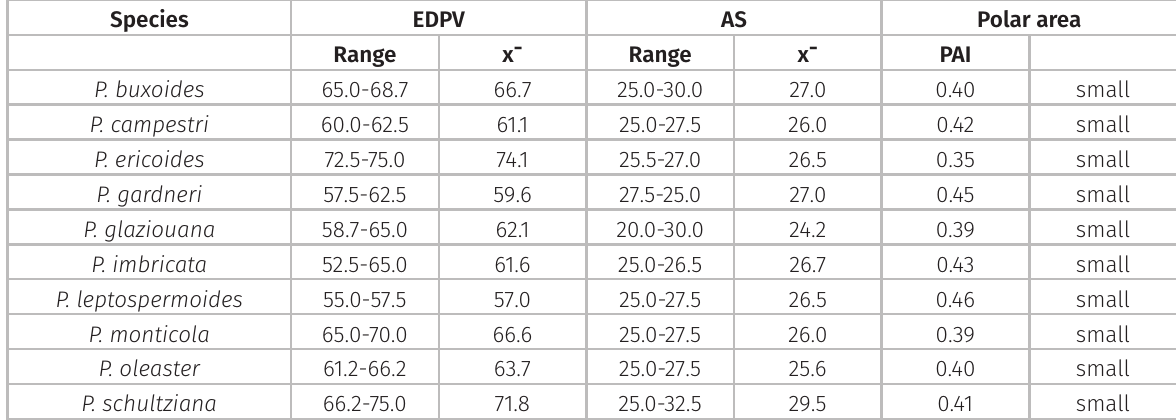
Table II. Measurements (in µm) of pollen grains in polar view: equatorial diameter (EDPV); apocolpus side (AS) and polar area index (PAI) of pollen grains of Piptolepis species (n=10). x - - arithmetic